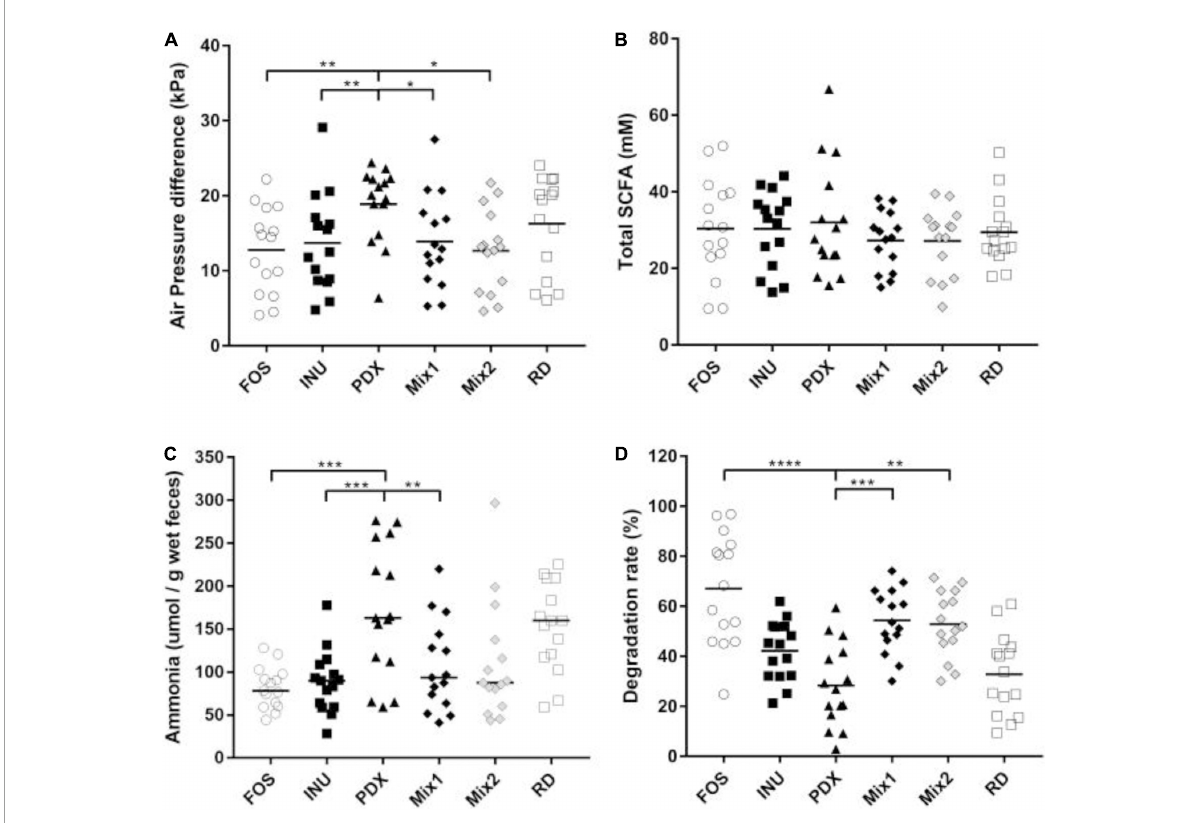
FIGURE1 Comparison of metabolic parameters after 24h in vitro fermentation. (A) The gas productions of different carbohydrate sources were determined by the air pressure difference of the vial. (B) The concentrations of the total SCFAs were determined by GC with the internal standard method. (C) The concentrations of ammonia in the fermentation broths were determined by colorimetry. (D) The degradations of each carbohydrate were determined by TLC. The data of fifteen volunteers are shown in scatter dot plot, the line is at medium. Only the significant differences between inulin (INU) and PDX are shown. * p value < 0.05, ** p value < 0.01, *** p value < 0.001, **** p value <